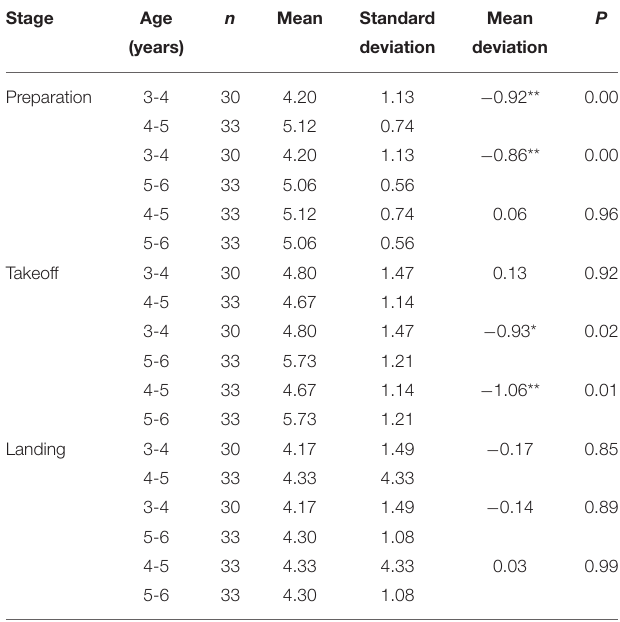
TABLE 4 | Comparison of the three-stage jump performance in children of different ages before the training intervention.